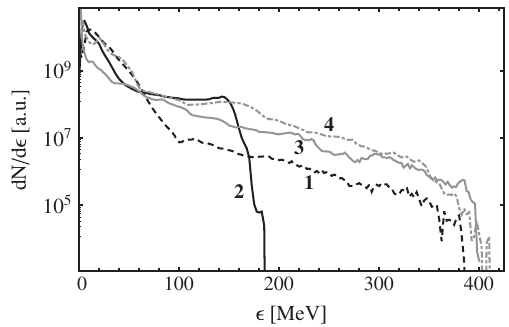
FIG. 5. Spectra of protons accelerated from the contamination layer of a solid foil (black curve, case 2) and a low-density target in cases 1, 3, and 4 (the respective dashed black, solid gray, and dash-dotted gray